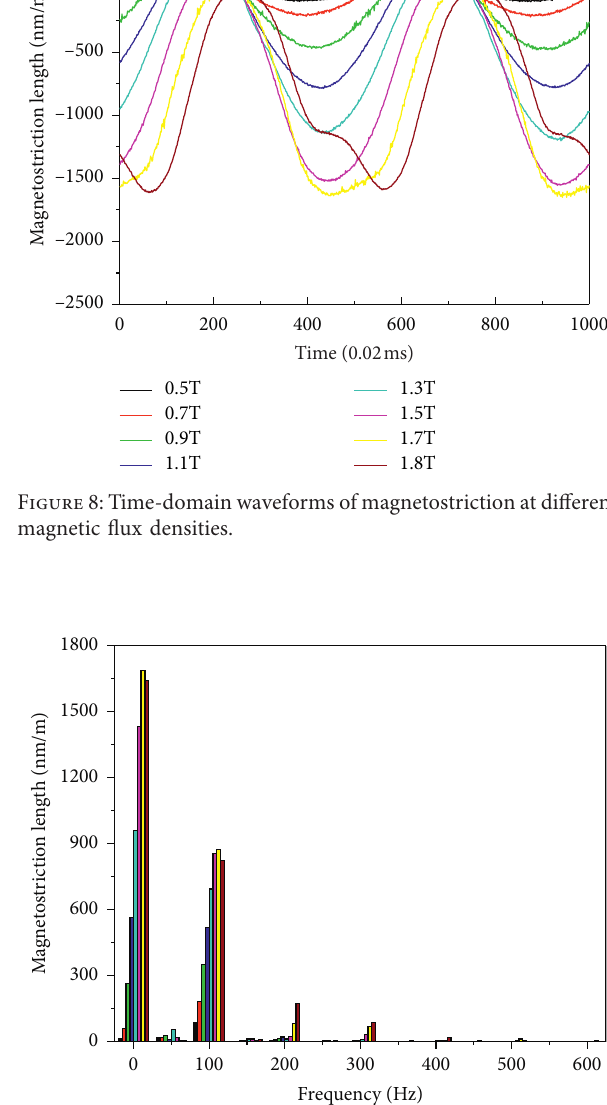
Figure 7: The magnetostrictive single-value curve.